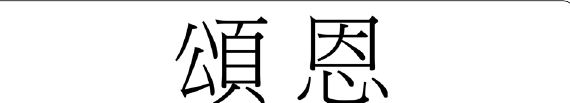
Fig. 2 Examples of Chinese characters with a left–right configuration (left) and a top–bottom configuration (right)